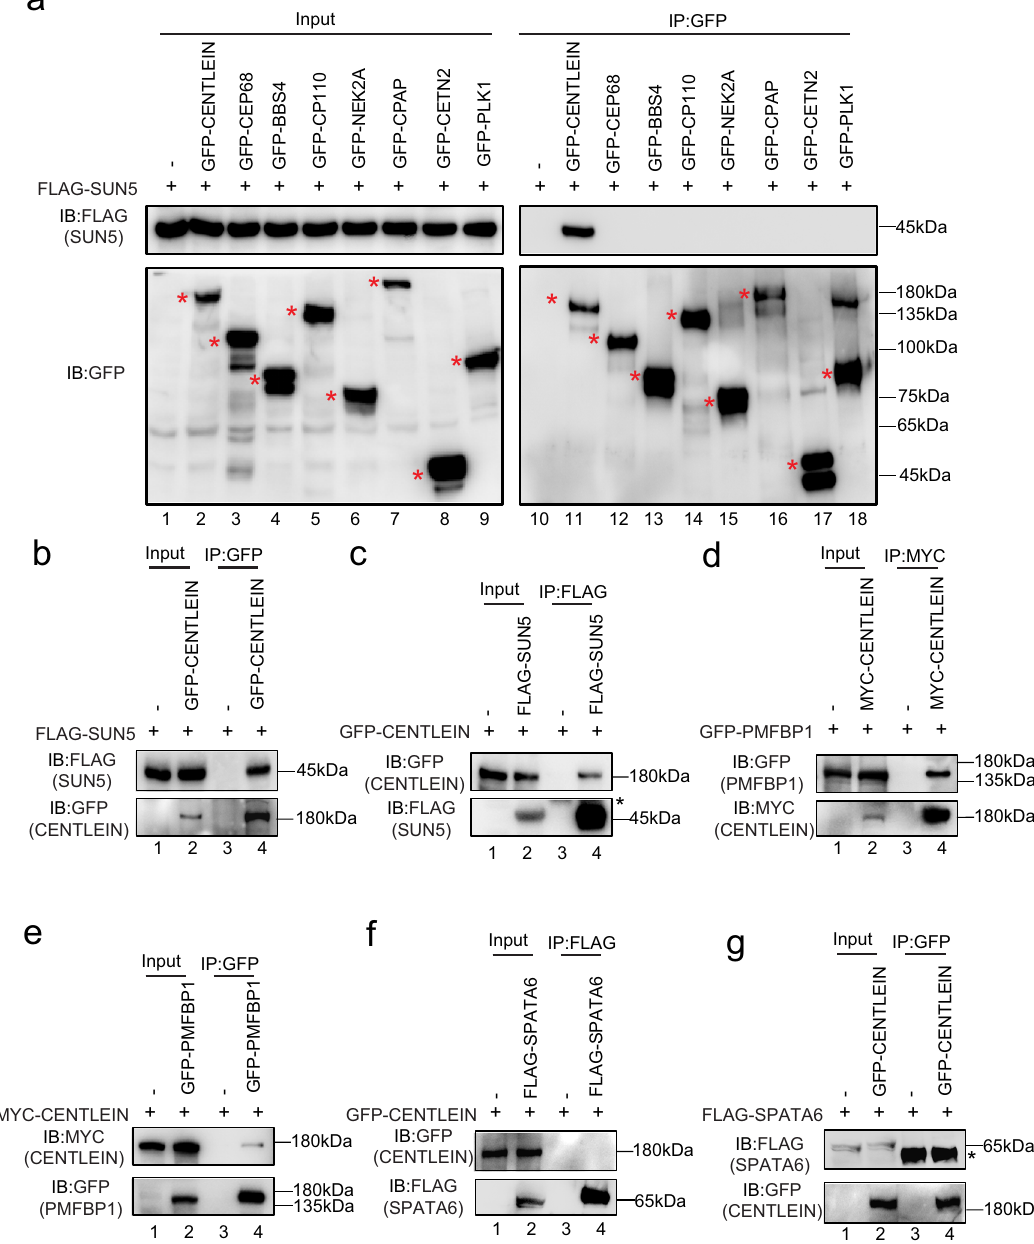
Fig. 1 CENTLEIN interacts with both SUN5 and PMFBP1. a A candidate-based approach by identi fi cation of SUN5-binding centrosomal proteins. FLAG- SUN5 and one of the GFP-tagged plasmid, including the empty vector, GFP-CENTLEIN, GFP-CEP68, GFP-BBS4, GFP-CP110, GFP-NEK2A, GFP-CPAP, GFP- CETN2, and GFP-PLK1, were co-transfected into HEK293T cells. Twenty-four hours after transfection, cells were collected for immunoprecipitation (IP) with anti-GFP antibody and analyzed with FLAG and GFP antibodies, respectively. Red asterisks indicate GFP-tagged proteins. b , c CENTLEIN could bind with SUN5. Empty vector, GFP-CENTLEIN and FLAG-SUN5 were co-transfected into HEK293T cells. Twenty-four hours after transfection, cells were collected for immunoprecipitation (IP) with anti-GFP antibody ( b ) or anti-FLAG antibody ( c ) and analyzed with FLAG and GFP antibodies, respectively. Asterisk indicates IgG heavy chains. d , e CENTLEIN could interact with PMFBP1. Empty vector, MYC-CENTLEIN, and GFP-PMFBP1 were co-transfected into HEK293T cells. Twenty-four hours after transfection, cells were collected for immunoprecipitation (IP) with anti-MYC antibody ( d ) or anti-GFP antibody (e) and analyzed with MYC and GFP antibodies, respectively. f , g CENTLEIN could not interact with SPATA6. Empty vector, GFP-CENTLEIN, and FLAG- SPATA6 were co-transfected into HEK293T cells. Twenty-four hours after transfection, cells were collected for immunoprecipitation (IP) with